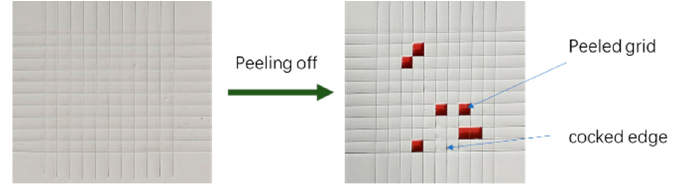
Figure 1. Schematic of interfacial strength evaluation.